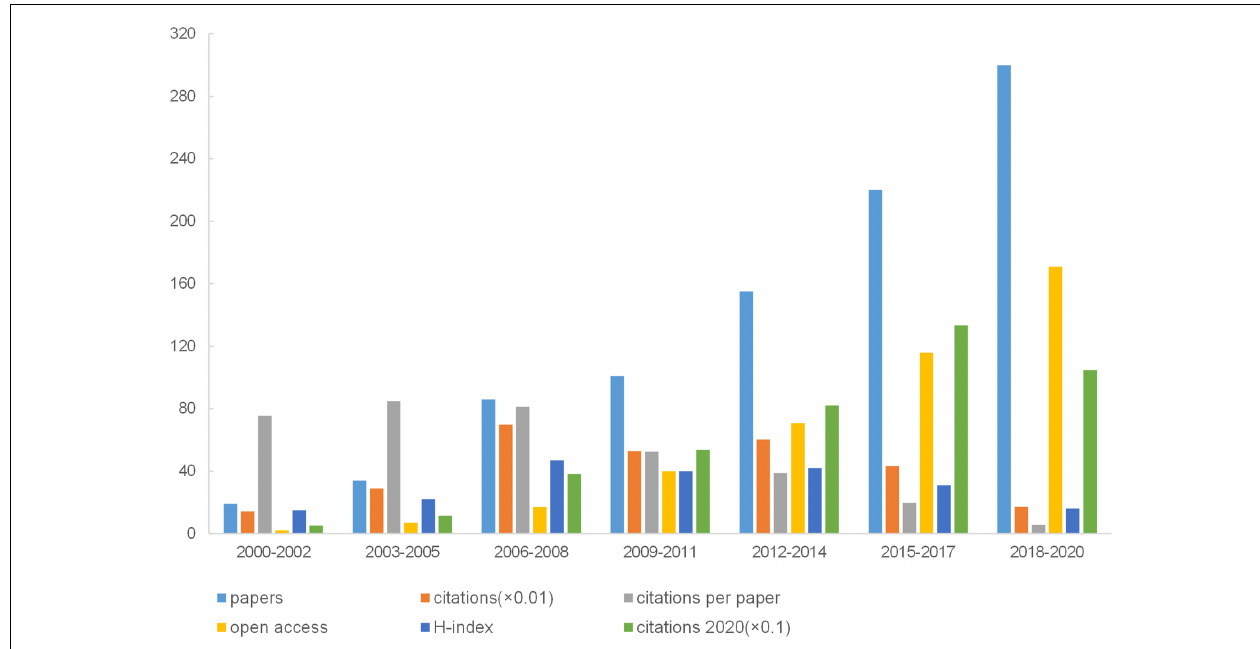
FIGURE 2 | Number of articles, citations, citations per paper, open access paper, H-index, and citations in 2020 for each 3-year time period.